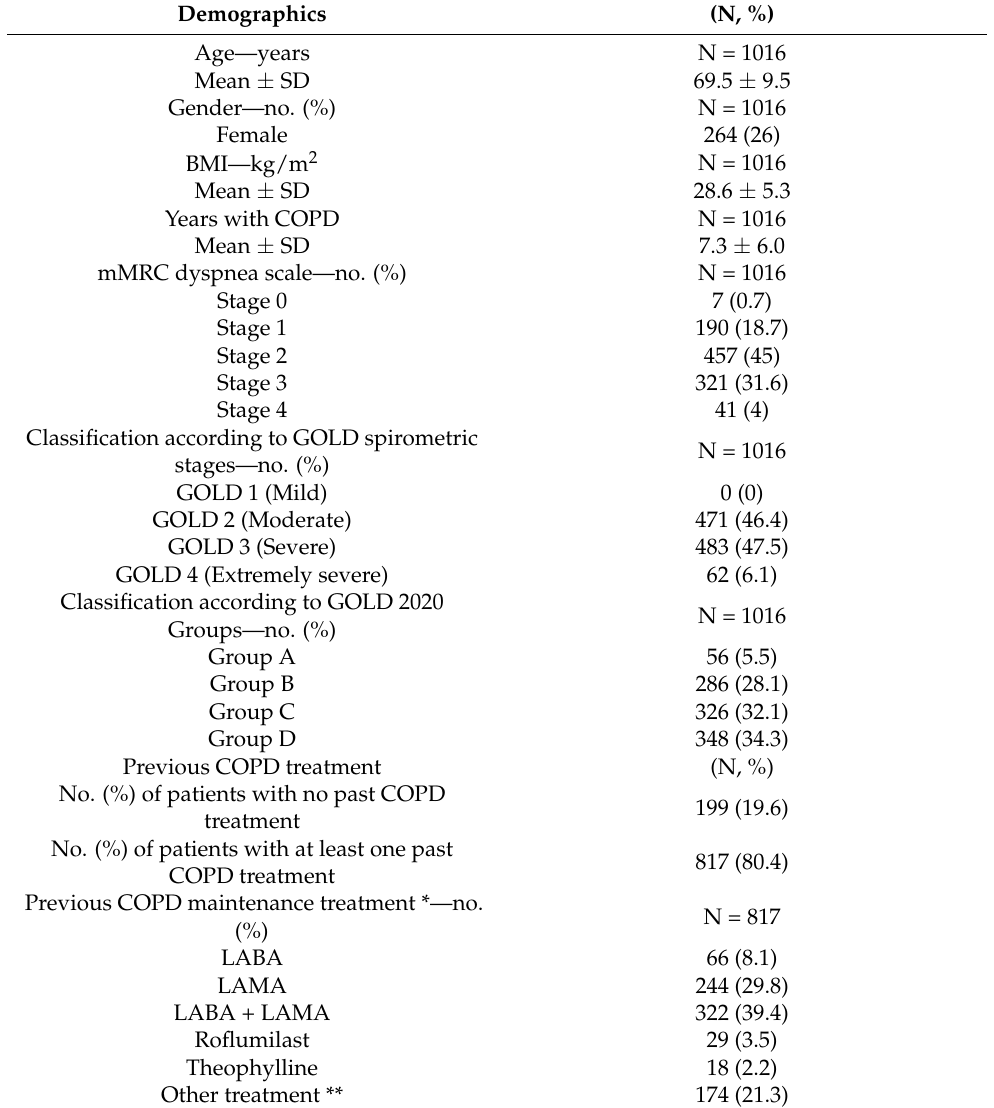
Table 1. Demographic and baseline characteristics of study